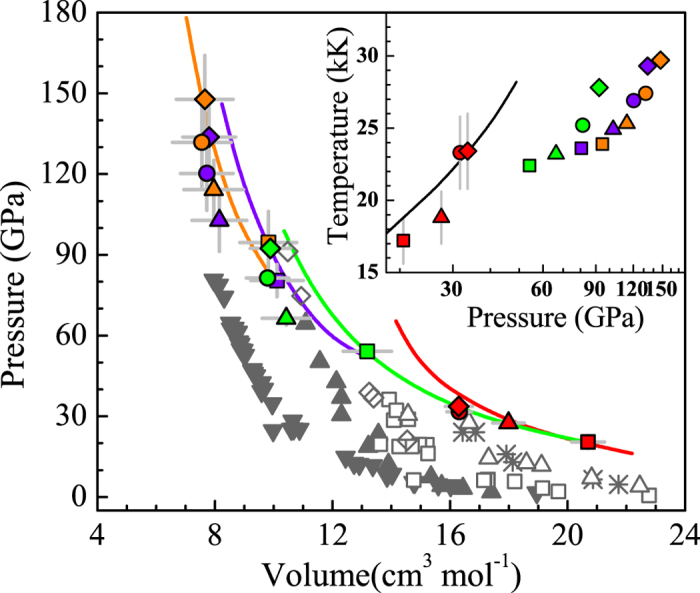
Comparison of argon shock data for different initial states and isotherm data for solid argon.The colored symbols represent the data of our work in the 1st (red), 2nd (green), 3rd (violet), and 4th (orange) shock compression. The solid curves were calculated from the corresponding lowest pressure point. For comparison, the dense argon results (open triangles28 and stars10), the liquid argon (open diamonds9 and open squares10), the solid argon Hugoniot (solid triangles8) and the solid argon isotherm (inverted solid triangles29) are also shown. Inset: The temperatures versus the pressure in our work are represented. The 1st shock data are measured and other data are calculated. The solid curve is the Hugoniot curve given by calculation.